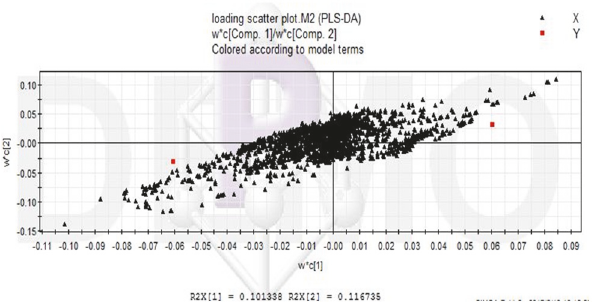
Figure 3: Load chart of PLS-DA pattern in treatment of liver failure with nonbioartificial liver.